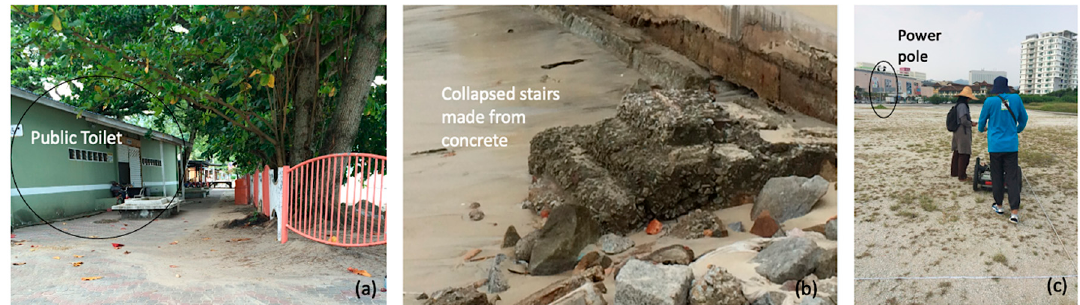
Figure 4. Noise during the GPR survey. ( a ) Anomalies in line 1 because of the existing public toilet including its underground pipeline system and well; ( b ) Man-made structure which is stairs made from concrete disrupted the wave activity and create sediments inclination in line 3, and ( c ) signal noise in line 8 resulted from the underground electrical wiring cable of the existing utility (power) pole. Refer to Figures 2 and 3 for detail positioning on the map.